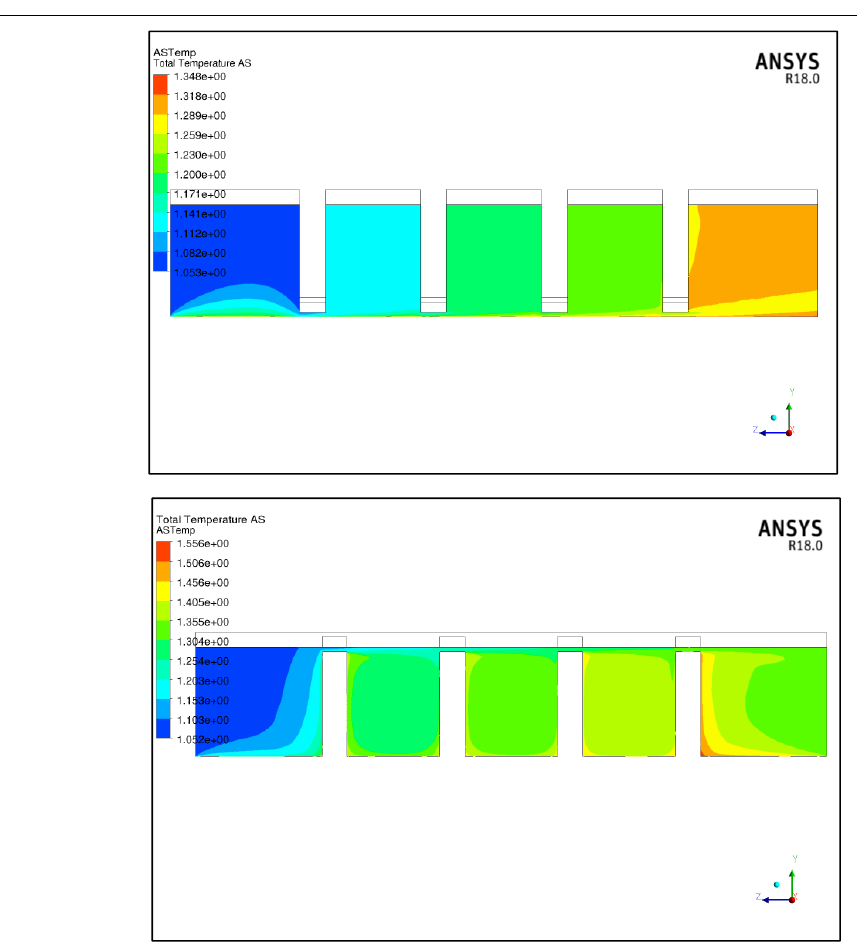
Table A6. Static pressure